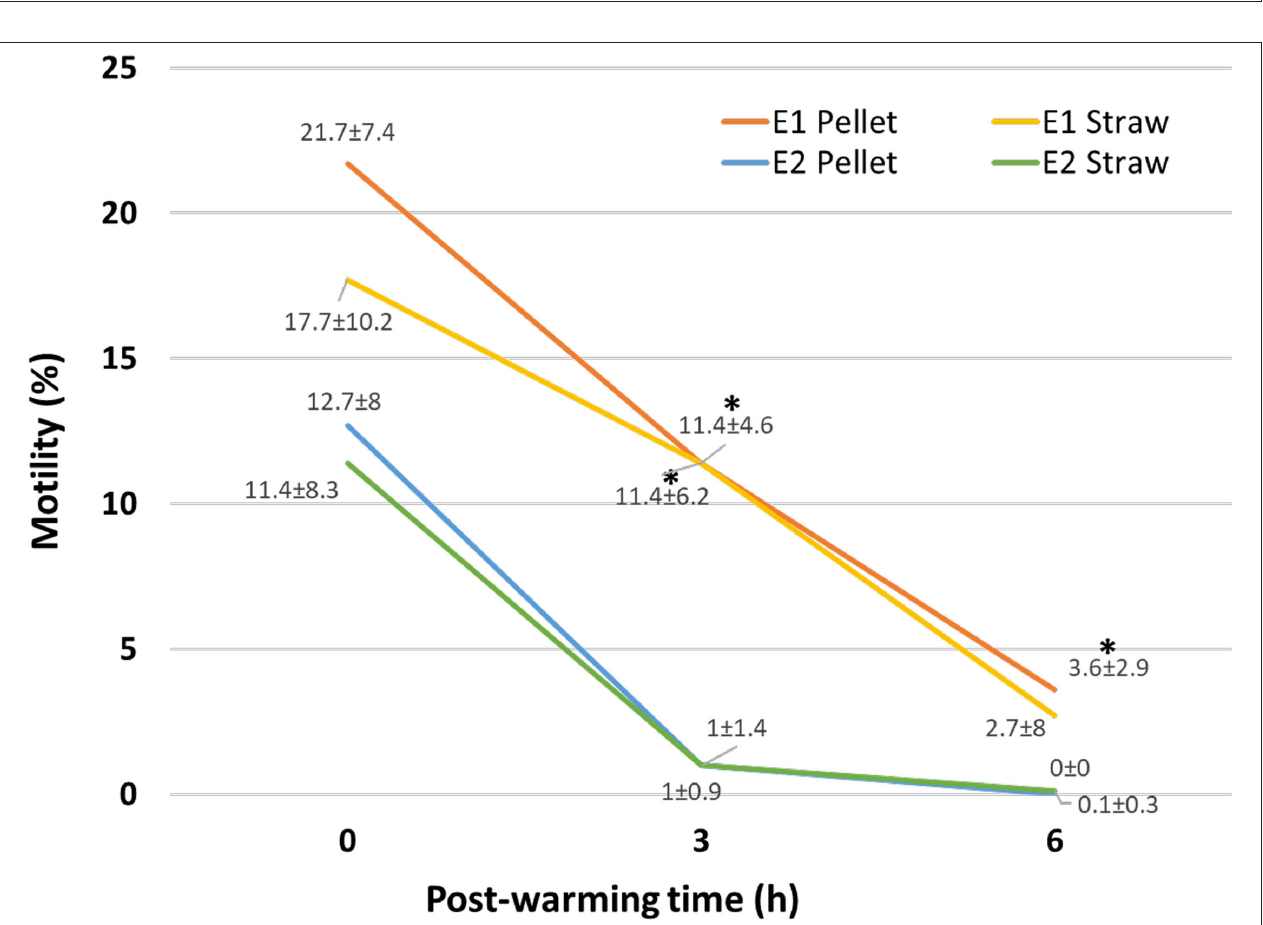
FIGURE 2 | Motility of ultra-rapid frozen cat epididymal spermatozoa after warming (0h) and 3h (3h) and 6h (6h) post-warming. Ultra-rapid freezing was performed with different extenders (E1, E2) and systems (pellet, straw). Within the same time point, *on E1, data indicate significant different values ( p < 0.05) vs. E2.